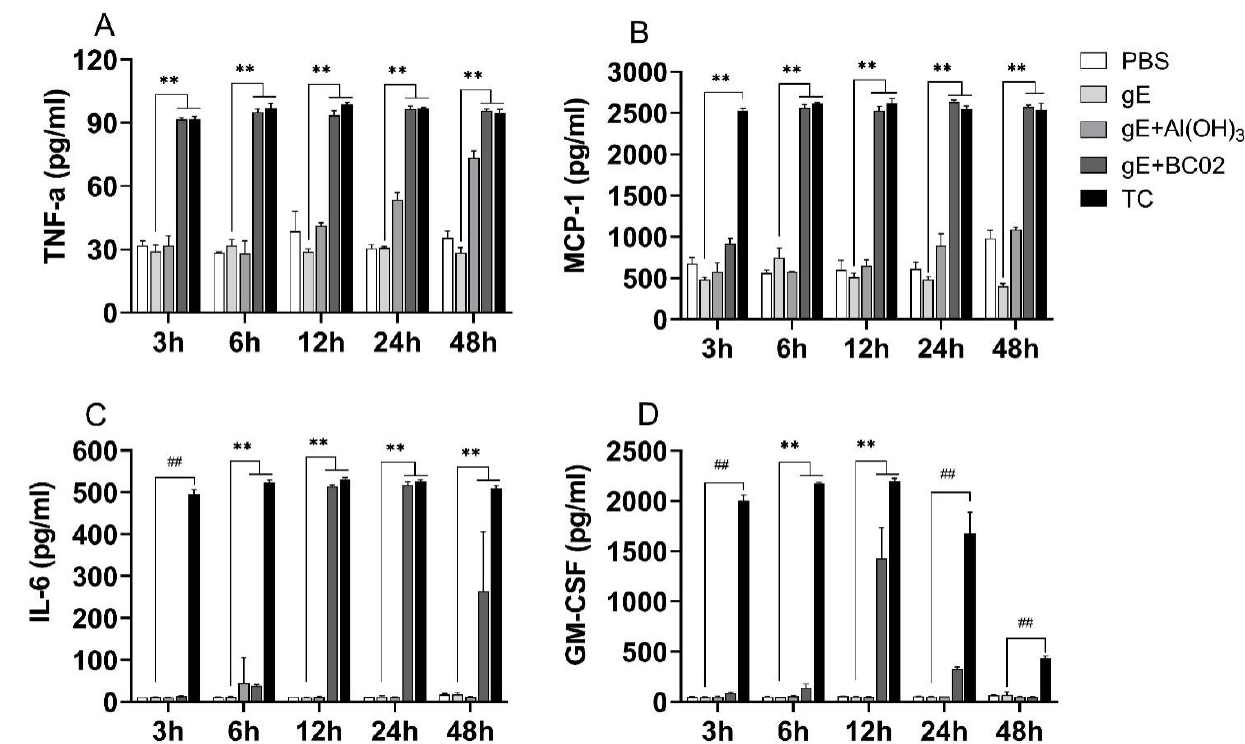
Figure 6. BC02-adjuvanted gE experimental vaccine stimulation induces secretion of cytokines by murine macrophages. ( A – D ): RAW264.7 cells were stimulated with 1/25 dose of experimental vaccine for different time points (3–48 h). Cell culture supernatants were collected, and the amount of TNF-a, MCP-1, IL-6 and GM-CSF levels were measured using ELISA. ** and ## indicates that there is a significant statistical difference between 1/25 dose of TC and gE + BC02 MD compared with gE group, or 1/25 dose of TC compared with the gE group, respectively, p < 0.05.